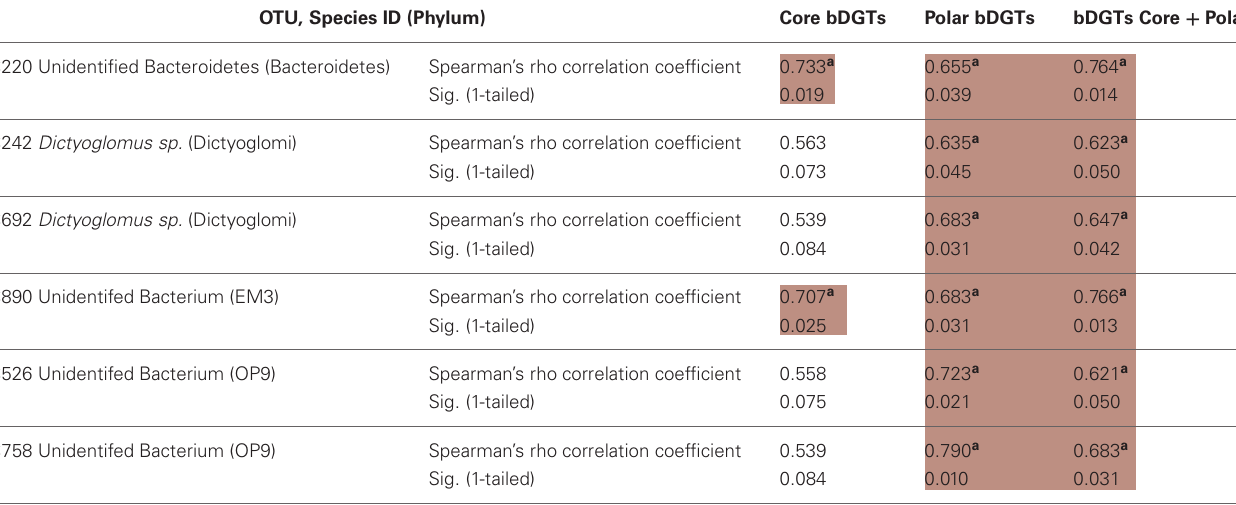
Table A3 | Correlations between normalized bGDGT concentrations (pg lipids/ng DNA) and relative abundance of dominant bacterial OTUs b